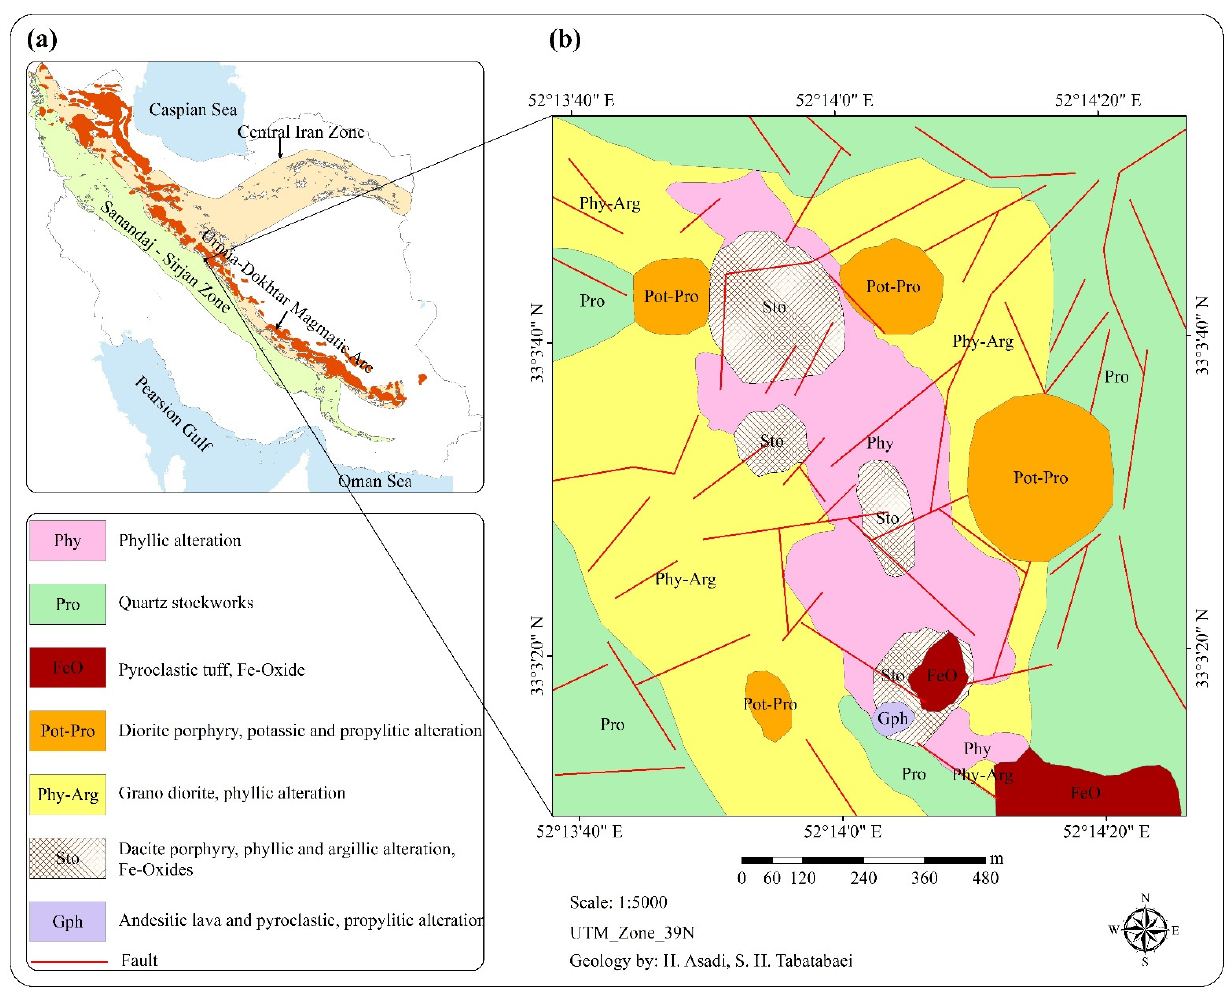
Figure 1. ( a ) The geographical location of the Zefreh area in the UDMA belt of central Iran; ( b ) geological map of the Zefreh area (scale 1:5000).